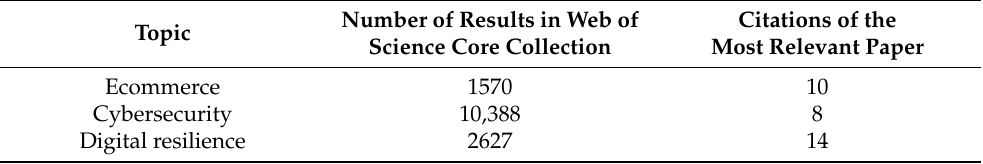
Table 2. Basic search results for topics of interest in the timespan between